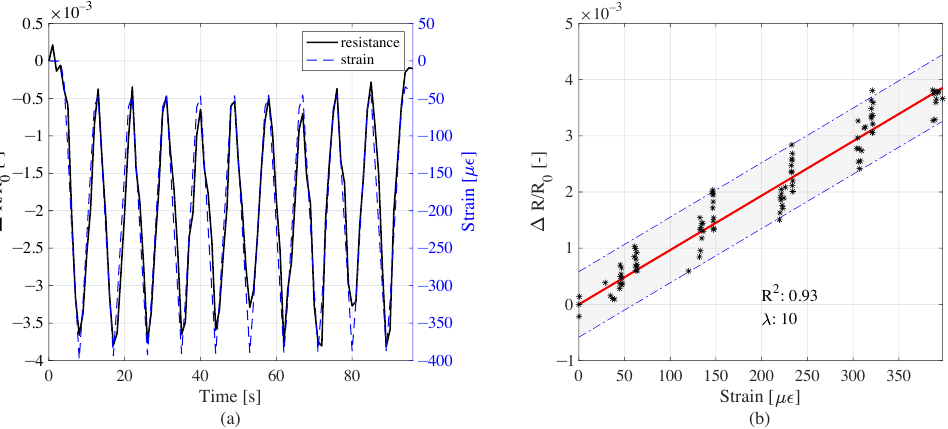
Figure 8. Sensitivity response of the cube sample under the cyclic compression load: ( a ) variation of resistance and the induced strain time histories; ( b ) resistance variation versus strain, and linear model of